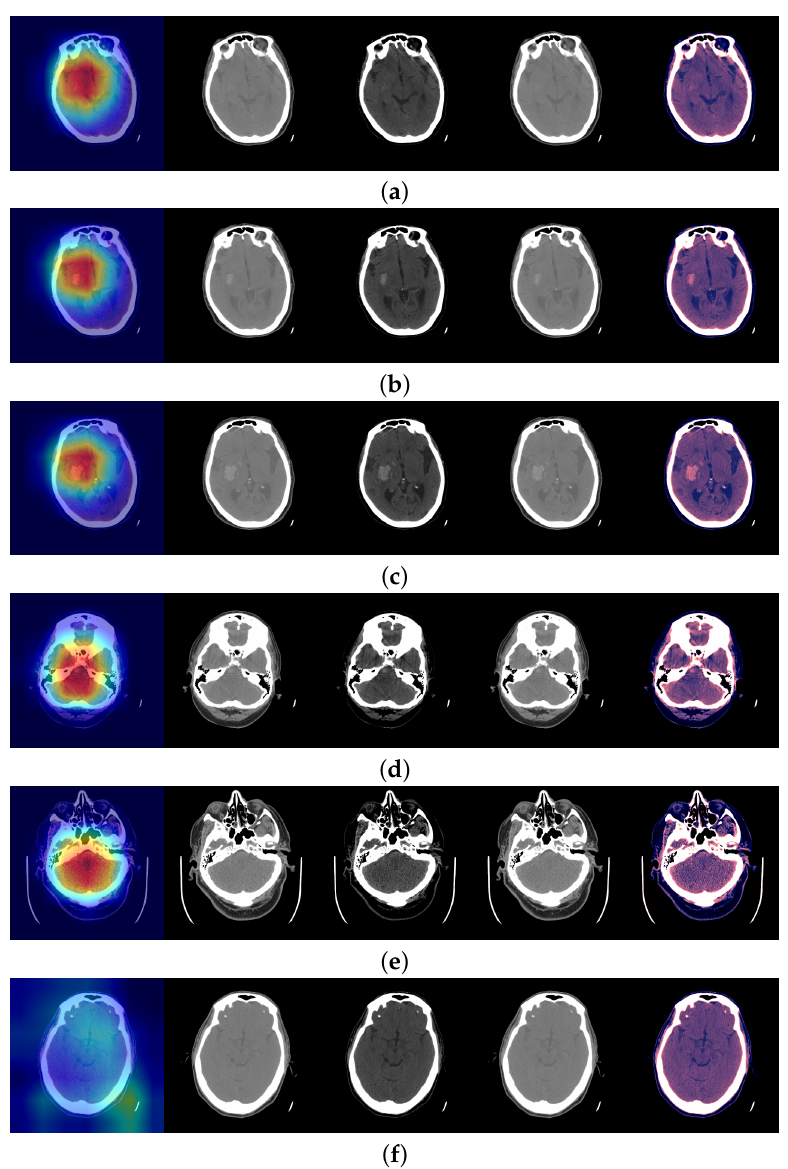
Figure 2. The model Efficient Classification predictions were all correct. In addition, Grad-CAM was able to focus on the bleeding area to make that decision. In each image, from left to right: Grad-CAM, [0.80] window, [ − 20, 180] window, [ − 150, 230] window, the three windows stacked. From ( a – f ) the probabilities of ICH in the slice are 0.9897, 0.9972, 0.9997, 0.7805, 0.8101 and